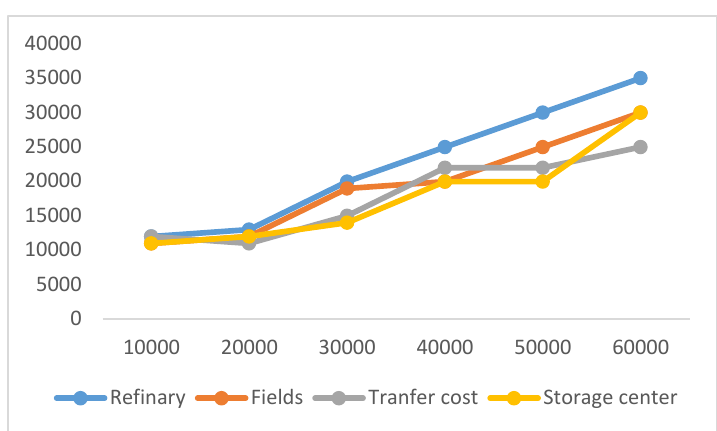
Fig 3. Changing maximum capacity on transfer costs.